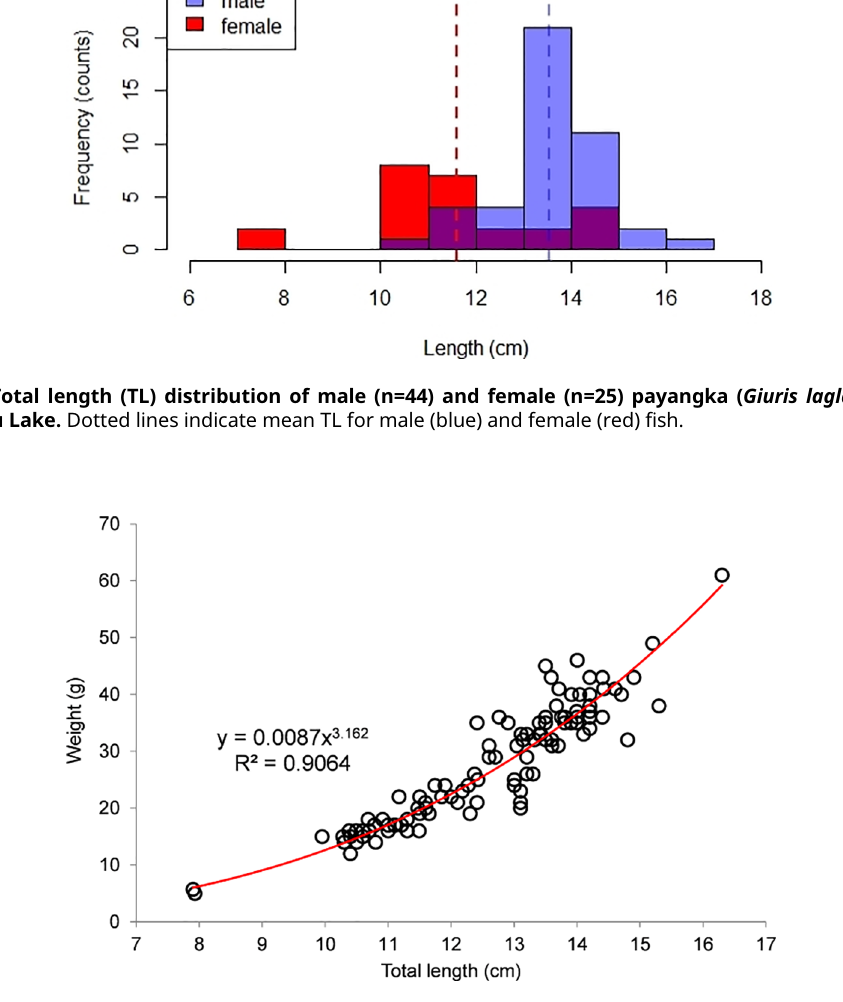
Figure 6. Length-weight relationship of payangka ( Giuris laglaizei ) from Bolano Sau Lake (n=107).